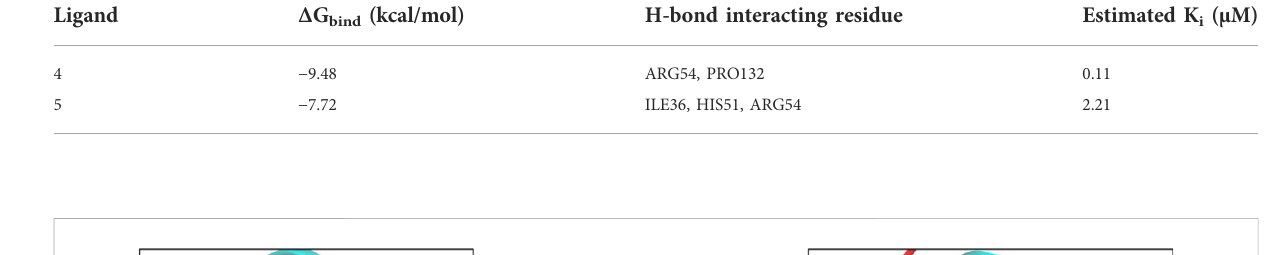
TABLE 2 The docking results of compounds 4 and 5 in the binding pocket of DENV2 NS2B-NS3 protease. Ligand